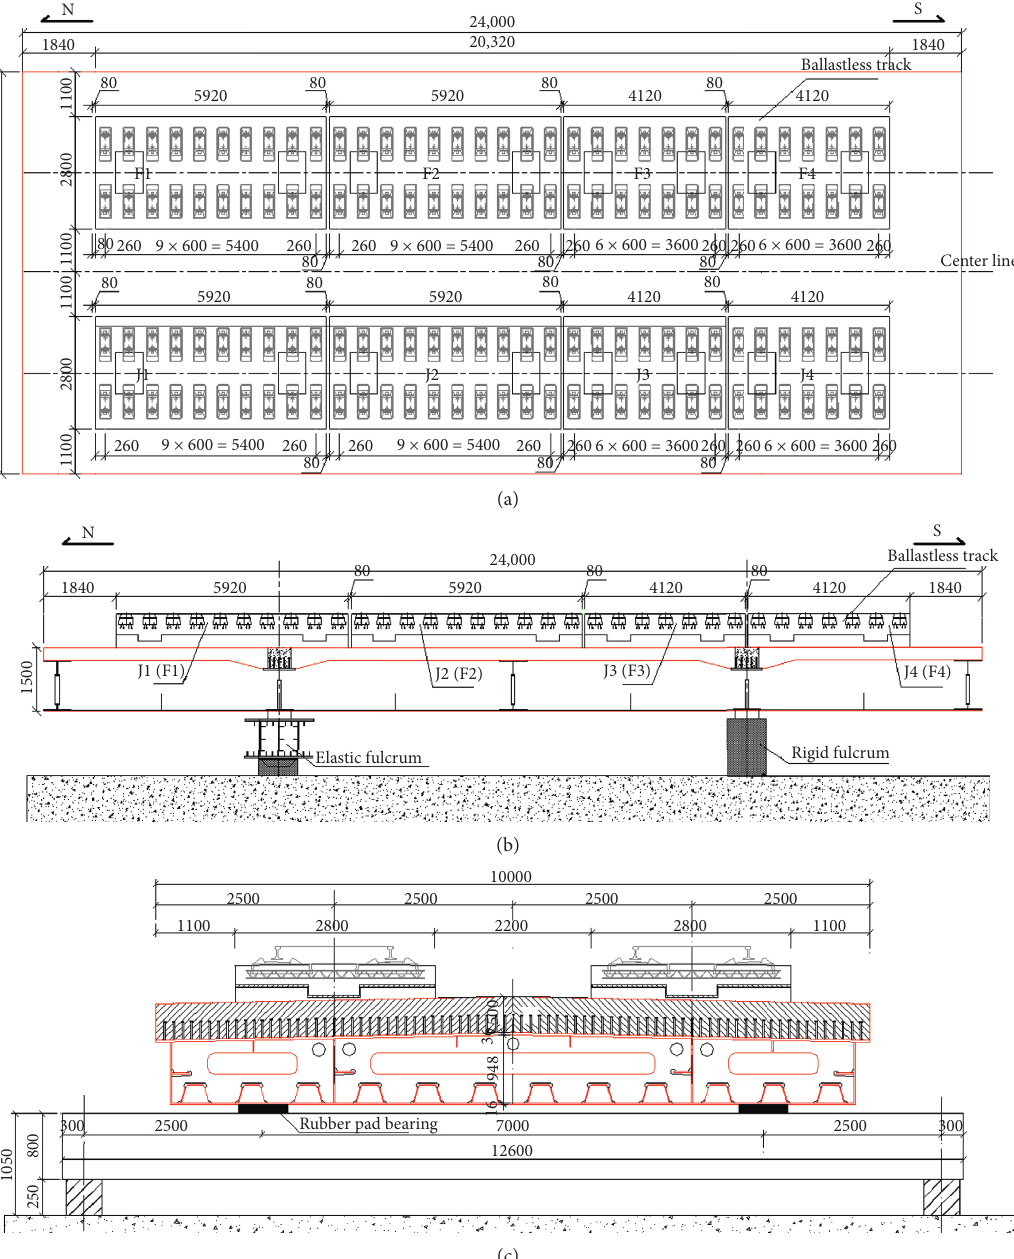
Figure 5: The simply supported box girder and ballastless tracks: (a) top view (unit: mm); (b) side view (unit: mm); (c) front view (unit: mm).